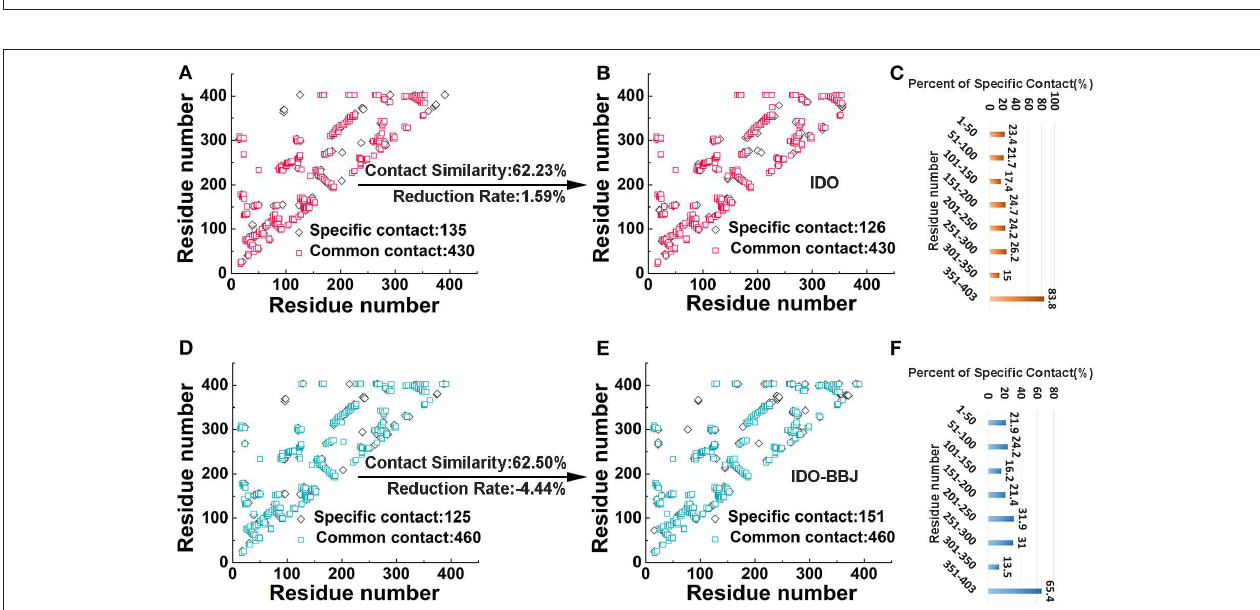
FIGURE 2 | Time-dependent conformational cluster analysis. Overview of clusters with RMSD threshold of 2.4 Å (A) . Cluster variations over simulation time in the IDO and IDO-BBJ systems (B) .